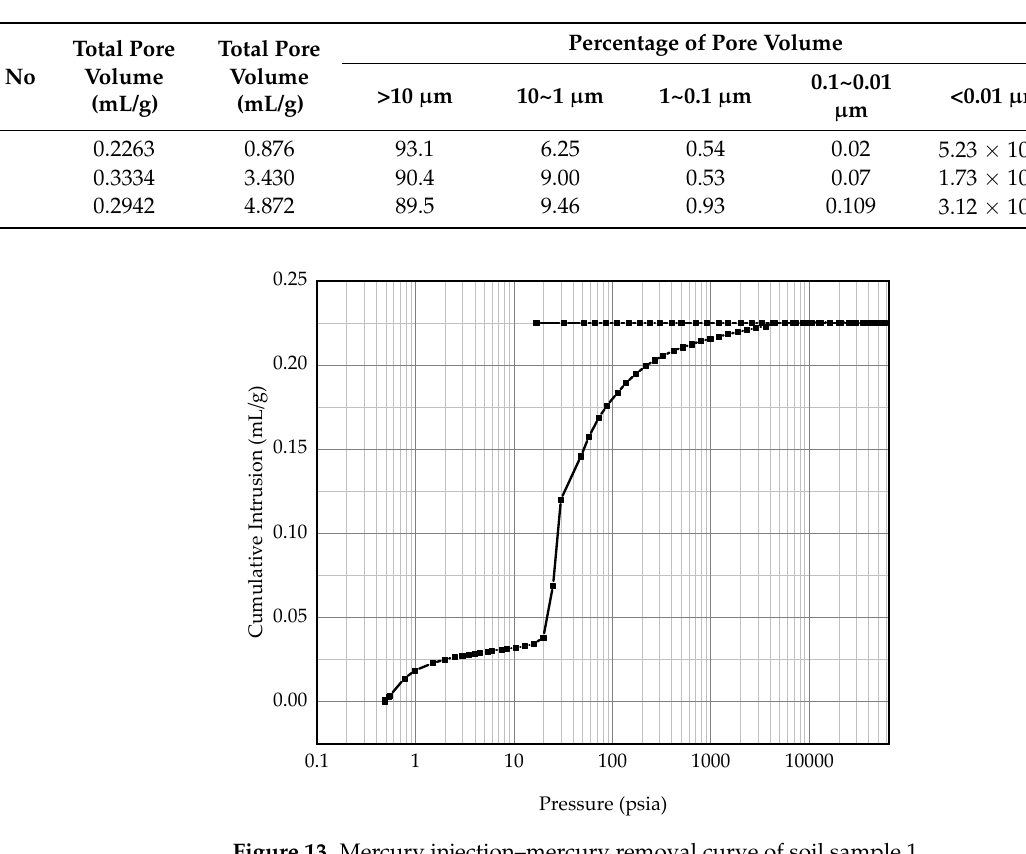
Table 10. Pore structure characteristic parameters of mercury intrusion test.